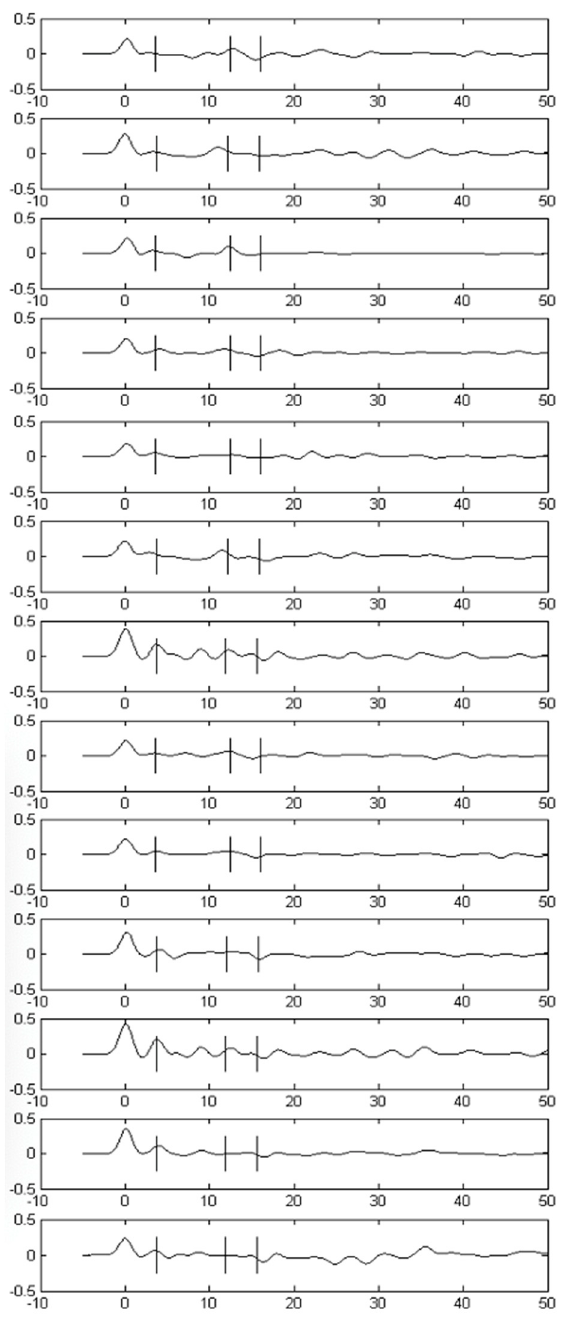
Figure 2. Receiver functions data from seismic station ARBA which are used in this article for testing the application of the generalized pattern search (GPS) algorithm. The three times t 1 , t 2 , and t 3 picked by the H- κ stacking algorithm for the three seismic converted phases (P-to-S converted phase (Ps), PpPs phase, and PpSs + PsPs phase) from the crust–mantle boundary (Moho) are shown with short vertical lines on each of the receiver function time series.